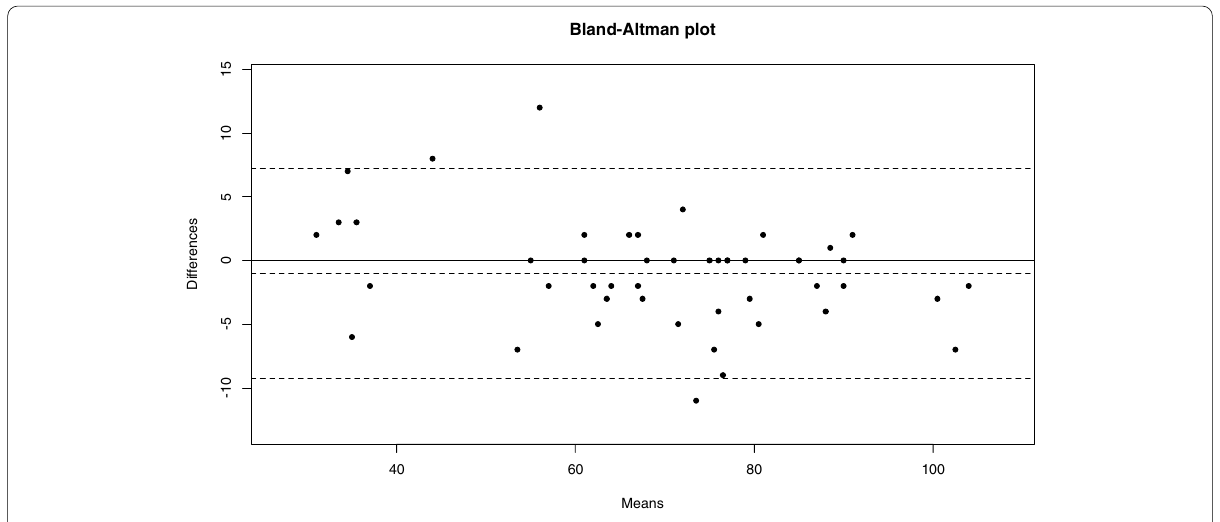
Fig. 2 Reproducibility of the SI‑RSI by Test‑Retest Bland‑Altman